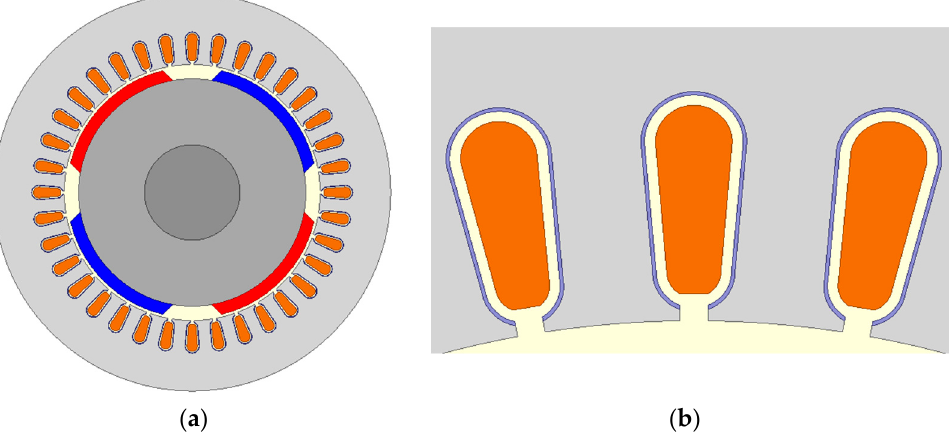
Figure 8. Two-dimensional reference simulation model for determining internal machine capaci- tances: ( a ) complete model view, ( b ) shaping the stator slot and winding.